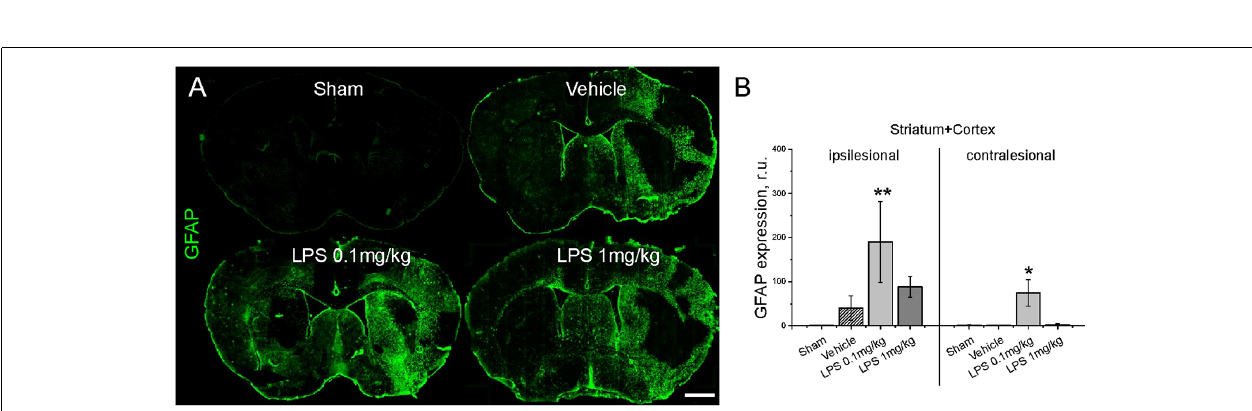
FIGURE 3 | Post-ischemic delivery of low dose LPS augments astrogliosis. Panel (A) shows representative immunostainings of glial fibrillary acidic protein (GFAP)+ reactive astrocytes. GFAP immunoreactivity is quantified in (B) in the entire ipsilesional and contralesional hemispheres (striatum plus cortex) of mice exposed to sham surgery or transient intraluminal MCAO. Vehicle or LPS (0.1 or 1 mg/kg) was intraperitoneally administered at 24 h after MCAO. Data are means ± SD values. * p < 0.05/** p < 0.01 compared with vehicle group ( n = 6 animals/group). Scale bars, 1 mm.